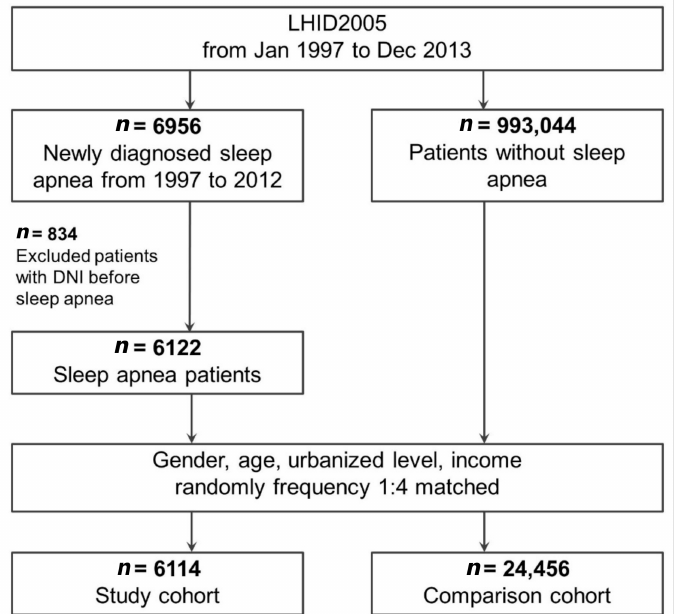
Figure 1. Flow of study patient identification and enrollment. Abbreviations: DNI, deep neck infection; LHID2005, Longitudinal Health Insurance Database